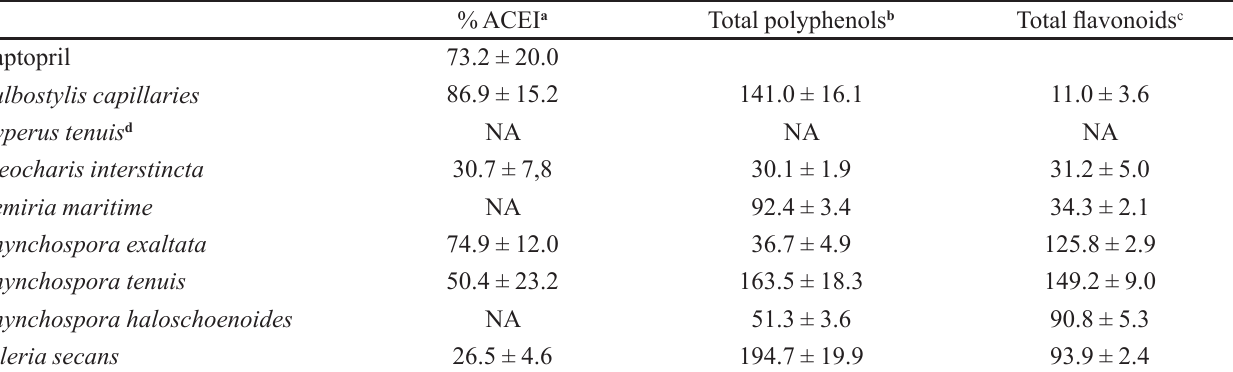
TABLE I - ACE inhibition percentages, total polyphenols and flavonoids amounts for the analyzed Cyperaceae